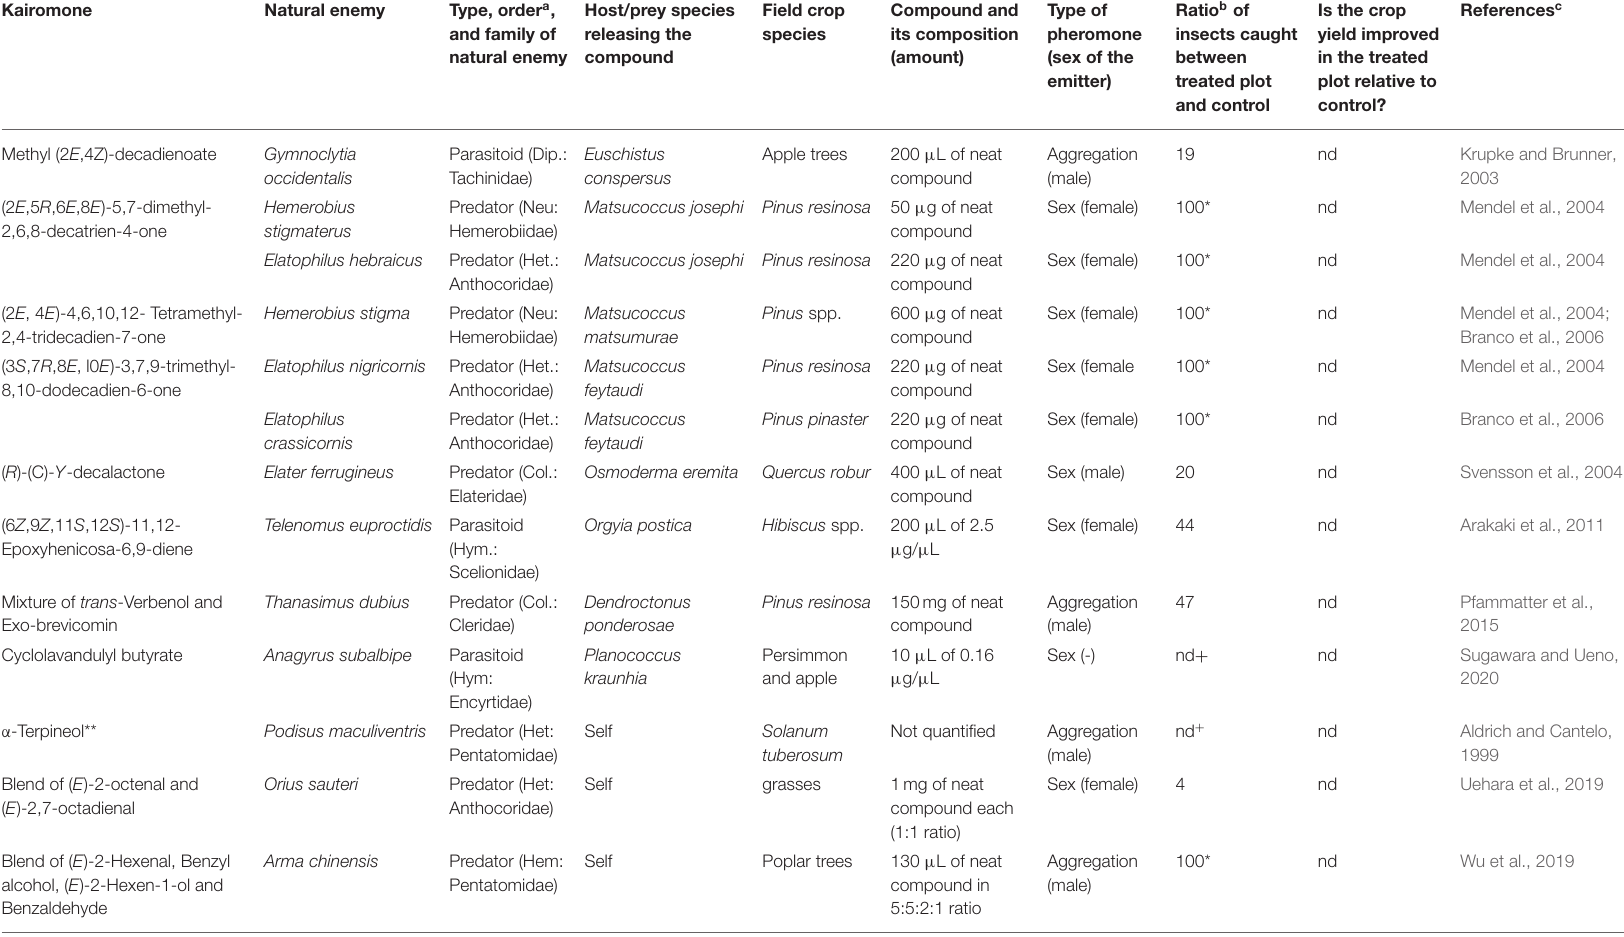
TABLE 2 | Summary of some pheromones applied in the field to attract natural enemies.